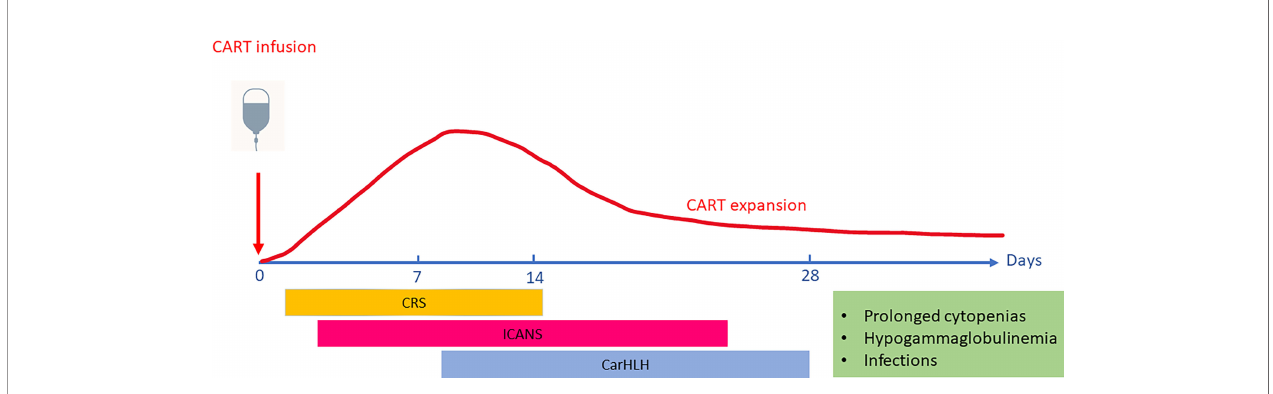
FIGURE 1 | Timing of Toxicities associated with CART cell (Chimeric-Antigen Receptor T-cell) therapies. CAR T cells typically expand and peak in the peripheral blood 1-2 weeks after infusion. The onset and peak of Cytokine Release Syndrome (CRS) generally occurs in the fi rst week after CART infusion and precedes the onset of ICANS (Immune Effector Cell-associated Neurotoxicity Syndrome). While CAR-associated Hemophagocytic Lymphohistiocytosis-like syndrome (CarHLH) manifestations may overlap with CRS, it has also been described as a separate entity emerging after resolution of CRS. Upon resolution of acute CART toxicities, patients are at risk for prolonged cytopenias, hypogammaglobulinemia and infectious risks due to ongoing B-cell aplasia mediated by persistence of functional CART